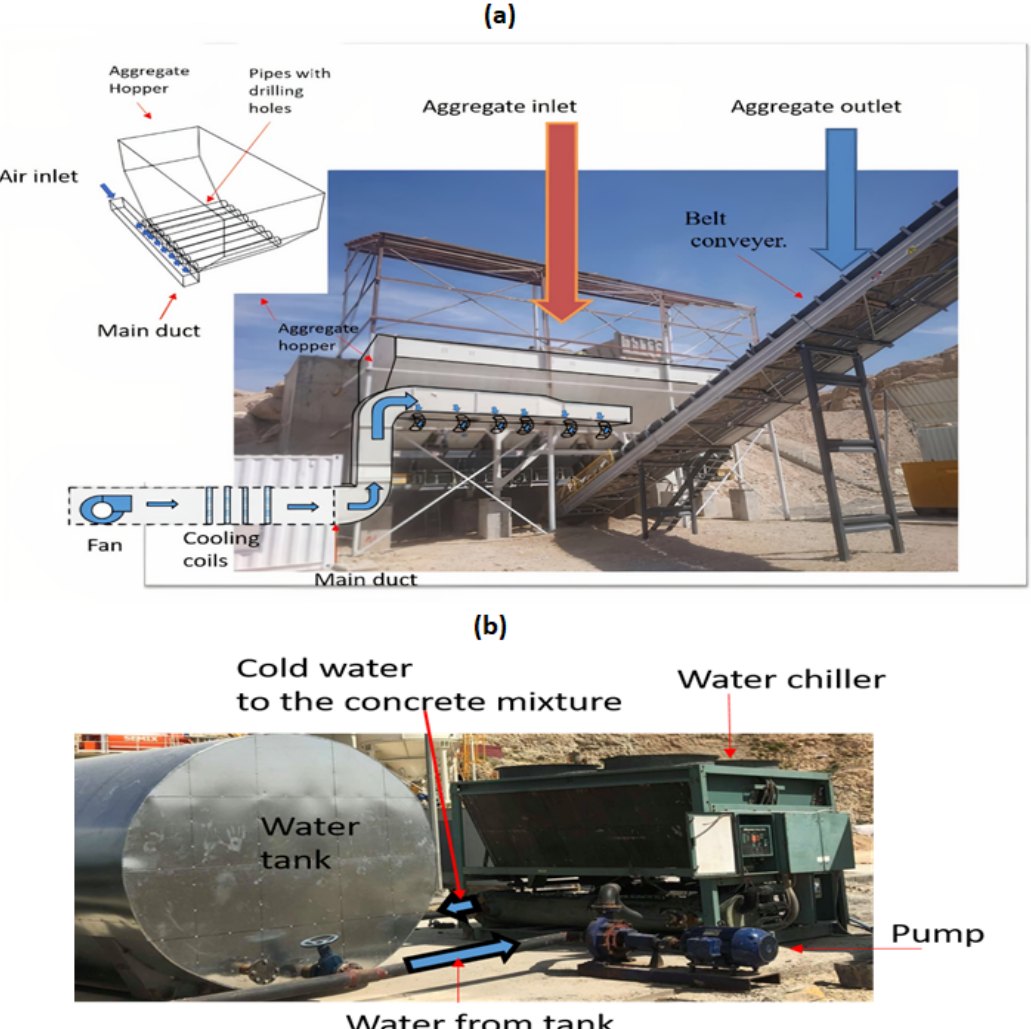
Figure 1. Two pre-cooling concrete mixture methods in the massive concrete structure; ( a ) Continuous aggregate cooling system and a description of the aggregate hopper and supply duct system; ( b ) Chilled water system.